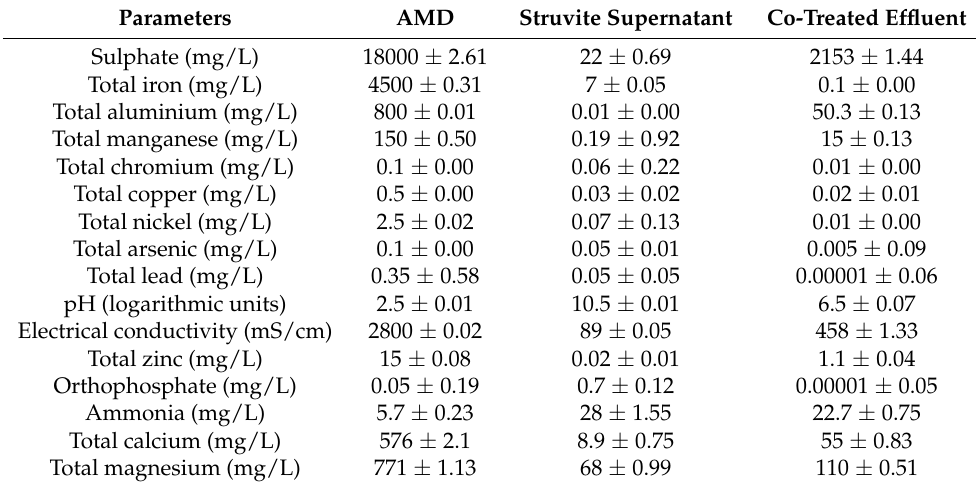
Table 1. Outcomes for the co-treatment of AMD with struvite supernatant at 1:9 ratio, 12 h equilibrium time, and room temperature ( n = 3 but results were reported as mean